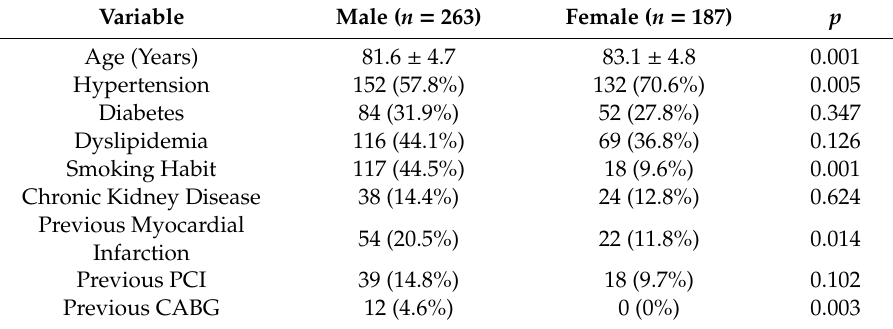
Table 1. Baseline